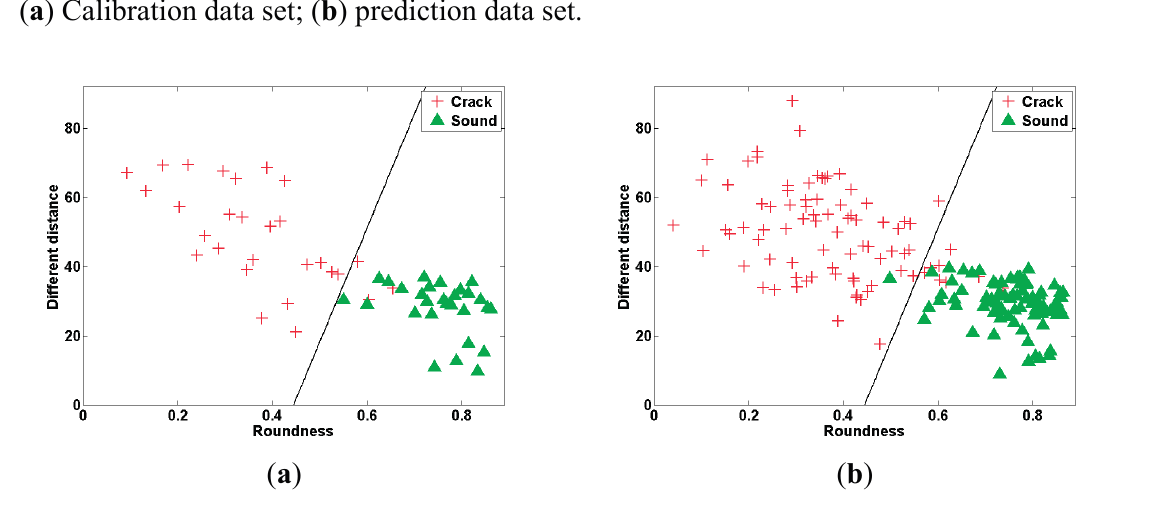
Figure 9. Classification of two features obtained from a PLS-DA binary image using